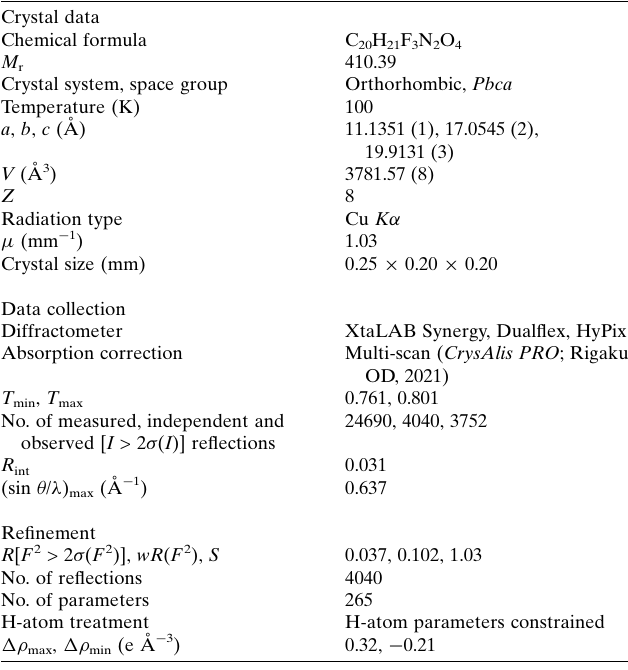
Table 3 Experimental details. Crystal data Chemical